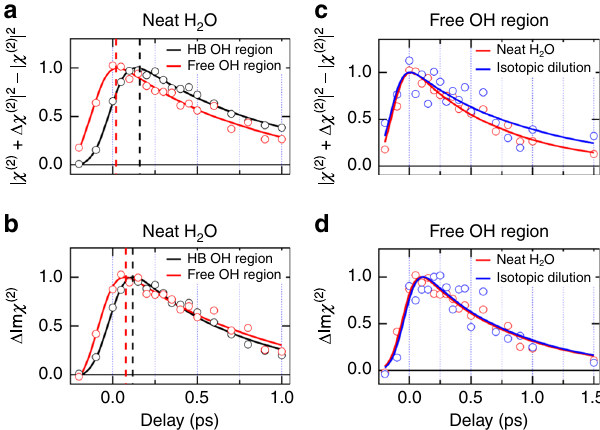
Fig. 5 Comparison between the temporal traces of the time-resolved VSFG signals obtained with homodyne and heterodyne detections. a Homodyne TR-VSFG signals and b time-resolved Δ Im χ (2) in the HB OH region (3500 cm − 1 , black) and the free OH region (3700 cm − 1 , red) at the air/neat H 2 O interface. Black and red dotted lines represent the peak of each temporal trace. c Homodyne TR-VSFG signals and d time-resolved Δ Im χ (2) in the free OH region at the air/neat H 2 O interface (red) and isotopically diluted water interface (blue). Homodyne TR-VSFG signals in a and c are calculated from the data obtained in the present TR-HD-VSFG measurements as | χ (2) + Δ χ (2) | 2 – | χ (2) | 2 . Solid lines are the exponential fi ts convoluted by the instrumental response (200-fs